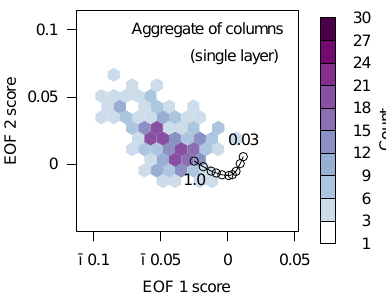
Figure 15. The distribution of retrieved EOF 1 and EOF 2 scores when using CALIOP data to filter out clouds with multiple lay- ers or with aerosols above the cloud. The observation frequency is color shaded, and the EOF scores for column aggregate particles (circles) are connected by a line. This analysis is conducted on a different EOF space from Fig. 6. The minimum degree of rough- ness is σ 2 = 0 . 03 and the maximum is σ 2 = 1 . 0. To exclude opti- cally thin clouds, pixels are selected if the CALIOP vertical feature mask product marks total attenuation above ground. No temperature threshold is